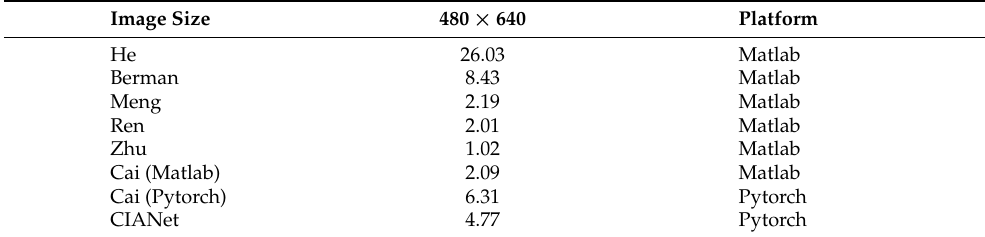
Table 5. Comparison of average model running time (in